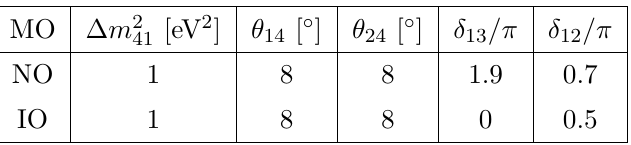
Table 1 . Benchmark sterile neutrino parameters from NOvA and T2K data from ref. [7]. Sterile parameters not shown are zero and standard oscillation parameters not shown are taken to the standard values shown in table